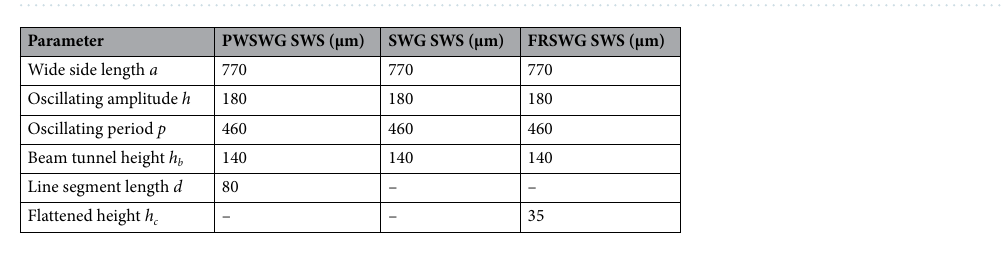
Table 1. Structural parameters of the PWSWG SWS, the SWG SWS and the FRSWG SWS.